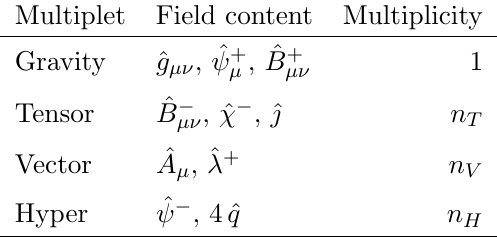
Table 1 . Field content of the di(cid:11)erent multiplets in 6d (1,0) supergravities. ^ g (cid:22)(cid:23) denotes the graviton, the ^ B (cid:22)(cid:23) are two-tensors, ^ (cid:22) , ^ (cid:31) , ^ (cid:21) and ^ are Weyl spinors (respectively the gravitino, tensorini, gaugini and hyperini), ^ | and ^ q are scalars, and (cid:12)nally ^ A (cid:22) is a vector. The signs on the fermions indicate their chirality, while those on the two-forms ^ B indicate (anti)-self-duality. We use hats on the (cid:12)elds to show that they are six-dimensional; later on, (cid:12)ve-dimensional quantities will be